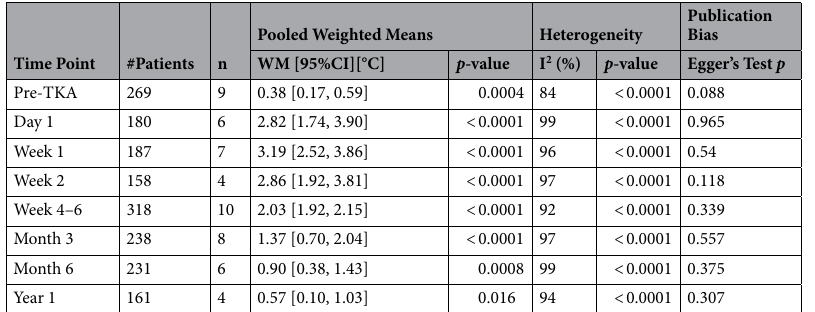
Table 3. Results of Meta-Analysis by Random Effect Model for Each Time Point. *n = number of studies; WM = weighted means of temperature difference between operated and non-operated knee in degrees Celsius (95% confidence intervals); Heterogeneity considered present if I 2 > 50% and/or p < 0.1; Publication bias considered significant if Egger’s p <